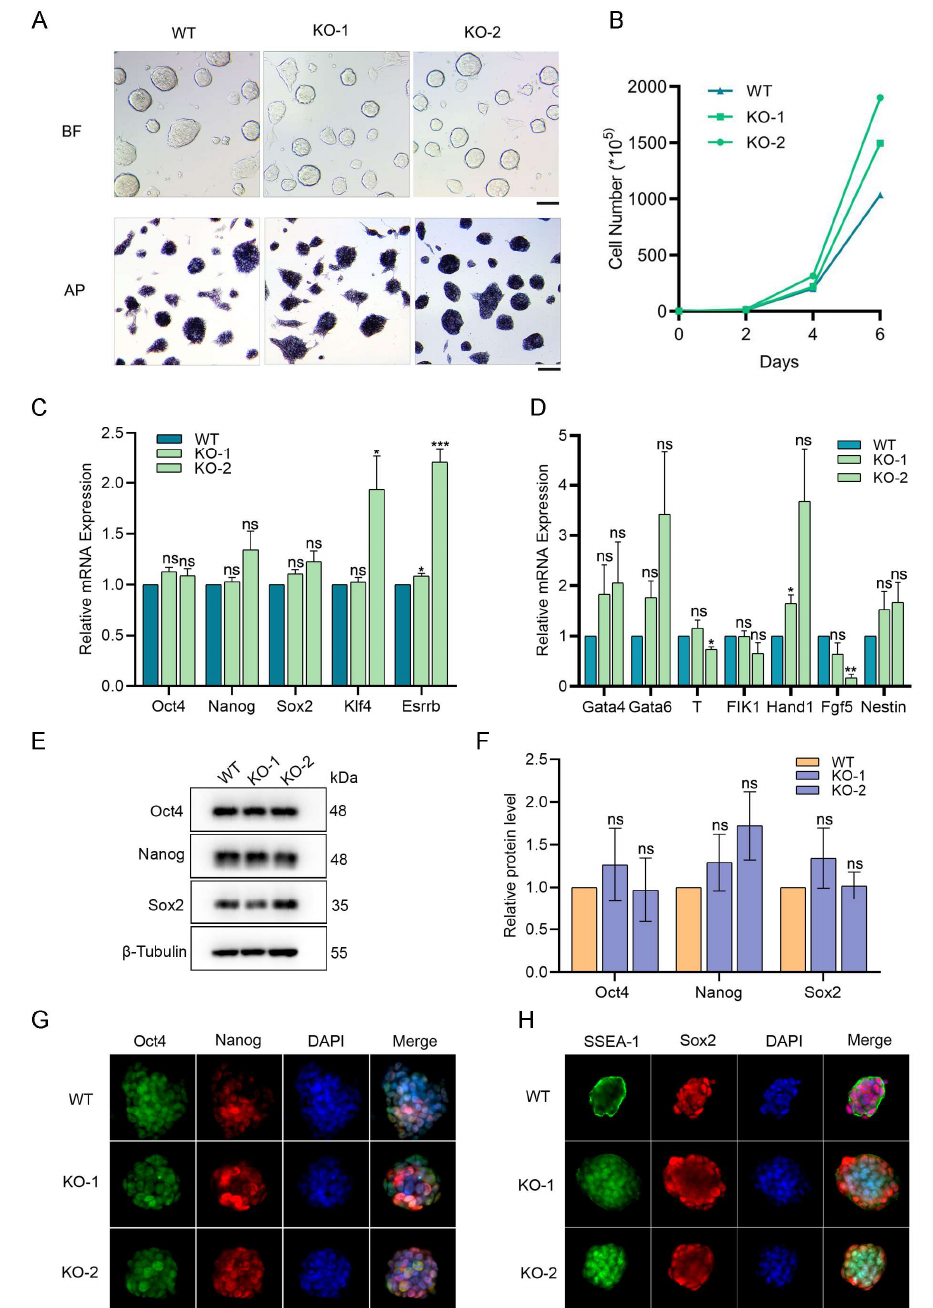
Figure 1. The self-renewal ability of ESCs is maintained upon Snap29 depletion. ( A ) Morphology of Snap29 +/+ (WT) and Snap29 − / − (KO) ESCs under bright field (BF) and alkaline phosphatase (AP) staining analysis. KO-1: -28 bp; KO-2, +1 bp. Scale bar, 100 µ m. ( B ) An accumulative growth curve of Snap29 +/+ and Snap29 −/− ESCs. ( C ) Expression analysis of pluripotent marker genes in Snap29 +/+ and Snap29 −/− ESCs by qPCR. ( D ) Expression analysis of lineage marker genes in Snap29 +/+ and Snap29 −/− ESCs by qPCR. ( E ) Western blot analysis of Oct4, Nanog, and Sox2 in ESCs. ( F ) Quantity using ImageJ software of pluripotent protein levels relative to β -tubulin as a loading control. ( G , H ) Immunofluorescence of the pluripotency-associated markers Oct4, Nanog, Sox2, and SSEA- 1. Scale bar, 25 µ m. Mean ± SEM from three independent experiments. * p < 0.05, ** p < 0.01, *** p < 0.001, ns not significant ( p > 0.05), unpaired two-tailed Student’s t -test, compared with WT